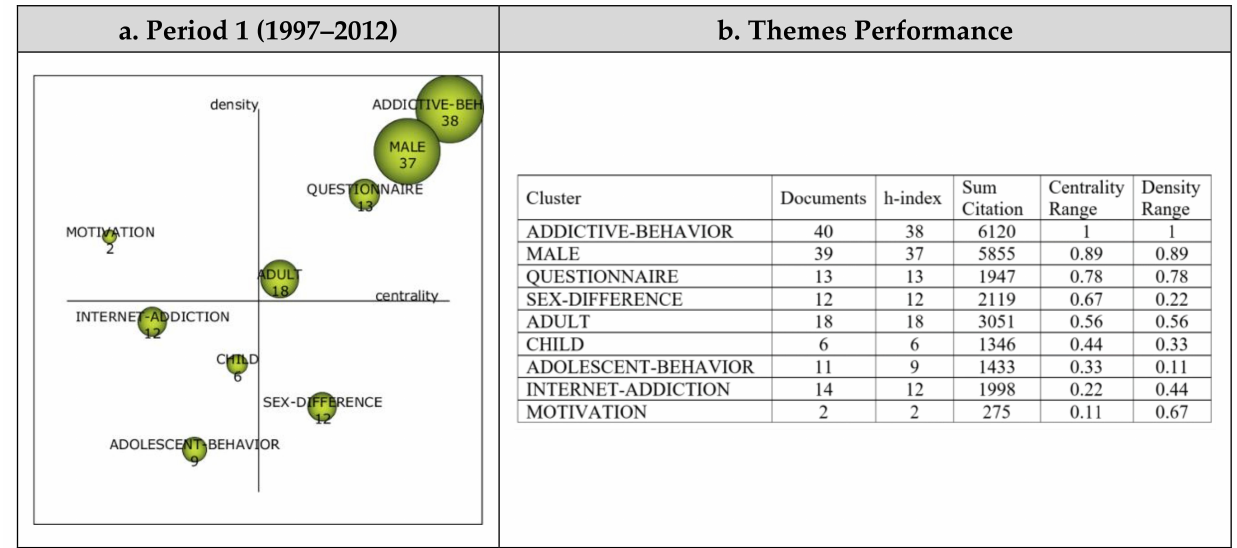
Figure 4. Period 1: ( a ) Strategic diagram and ( b ) performance